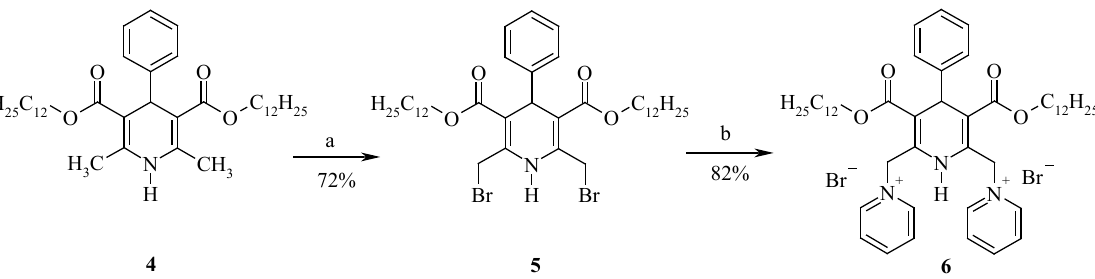
Scheme 1. Synthesis of cationic amphiphilic 1,4-DHP derivative 6 . Reagents and conditions: a) NBS, MeOH, rt, 20 h; b) Pyridine, Acetone, rt, 48